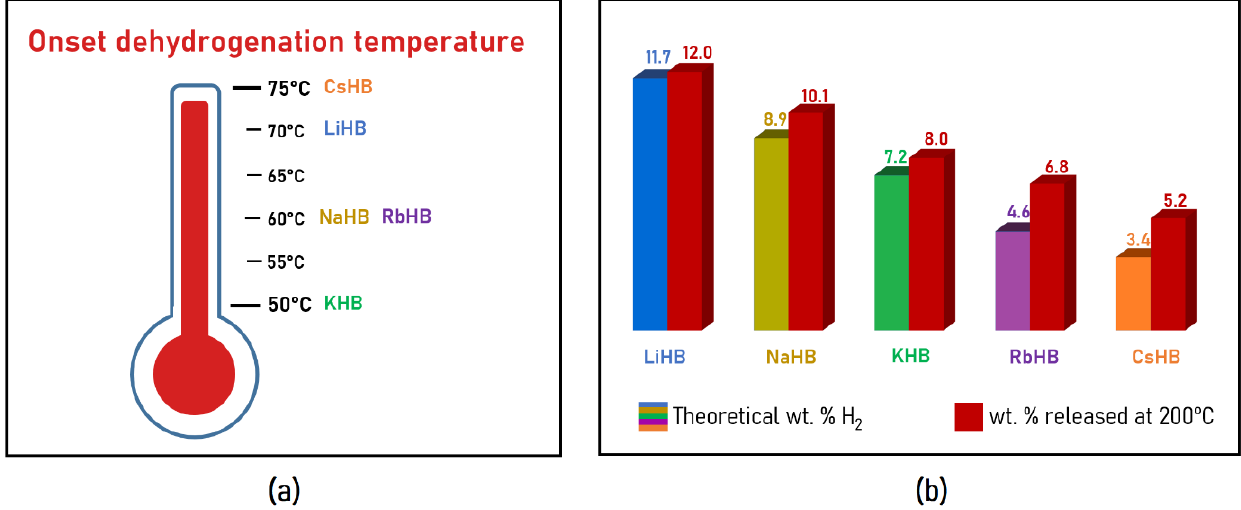
Figure 19. ( a ) Onset temperature of dehydrogenation; ( b ) theoretical hydrogen gravimetric capacity vs. weight loss at 200 °C of the alkali hydrazinidoboranes.